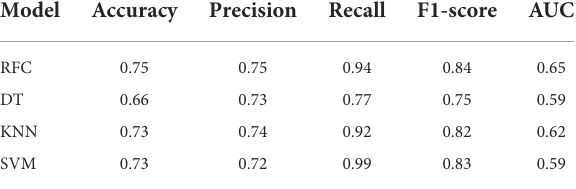
TABLE 3 Result of cross-validation on training dataset ( n = 2,804). TABLE 4 Model performance on testing